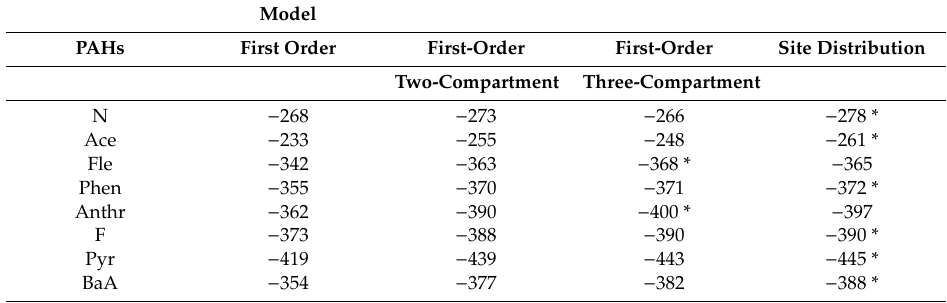
Table A1. Several models were tested to describe the PAH desorption kinetics. The Bayesian information criterion (BIC) values were calculated as follows to determine the best model for each PAH